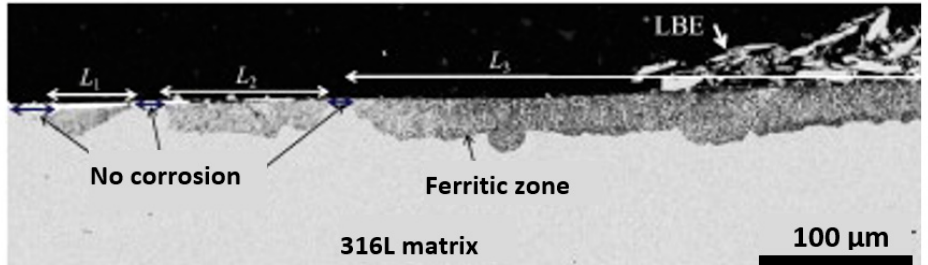
Figure 3. SEM cross-section image showing ferritic zones in stainless steel sample after 3045 h at 500 °C in 10 − 8 wt.% oxygen LBE, from [29]. L 1 , L 2 and L 3 are the length of the ferritic layer. For martensitic steels, homogeneous dissolution occurs promoting more (e.g., [18,33]) or less pronounced relief which may act further as a stress raiser, see Figure 4.